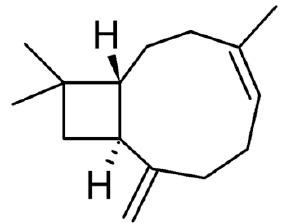
Figure 1. Chemical structure of β -caryophyllene (CRY).